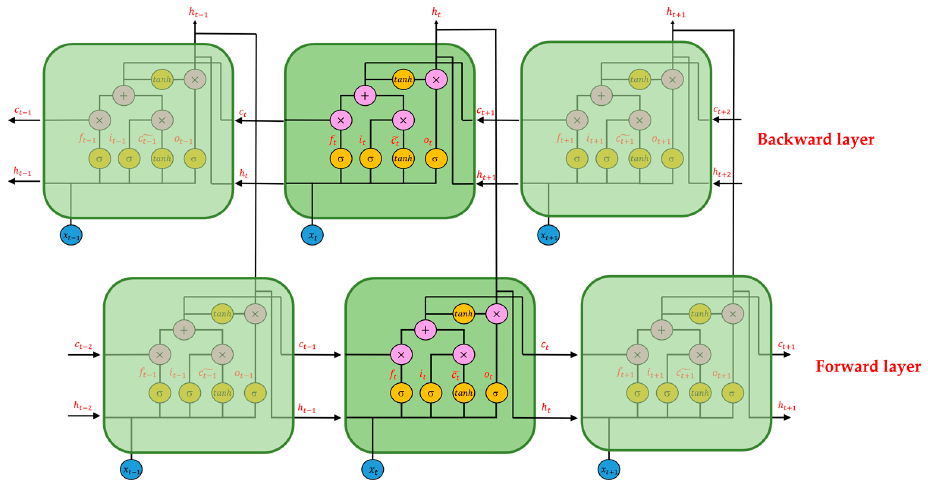
Figure 7. Structure diagram of Bi-LSTM.